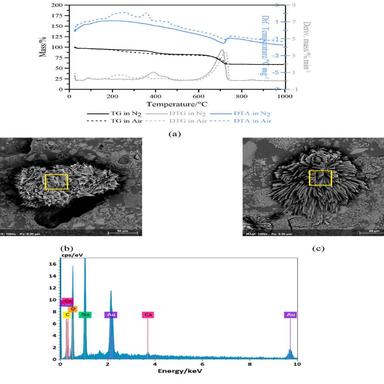
Microanalysis of powder CA: (a) TG, DTG and DTA curves under air and N2 atmosphere conditions (b) BSE image by SEM of well-defined reticulated structure, (c) BSE image by SEM of lamellar structure, and (d) a typical EDS spectrum of regions highlighted in yellow. (For interpretation of the references to colour in this figure legend, the reader is referred to the Web version of this article.)